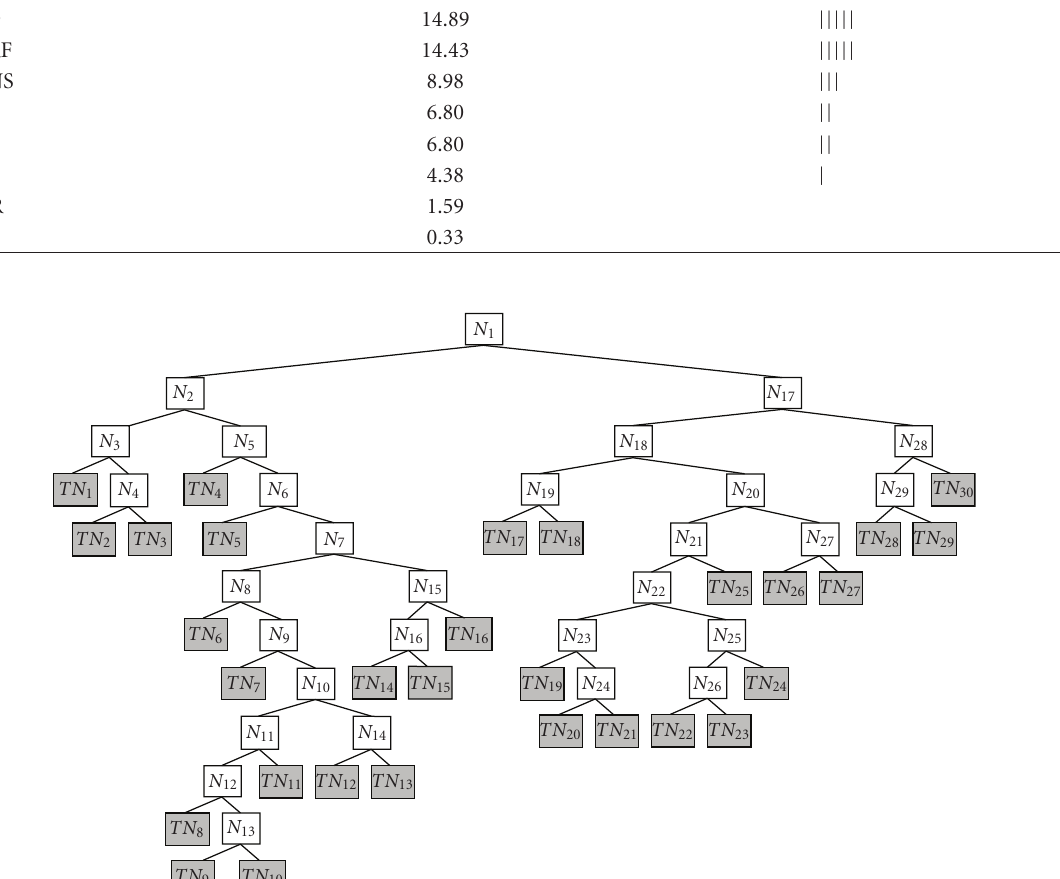
Figure 5: Topology of a general classification tree for bridge deterioration